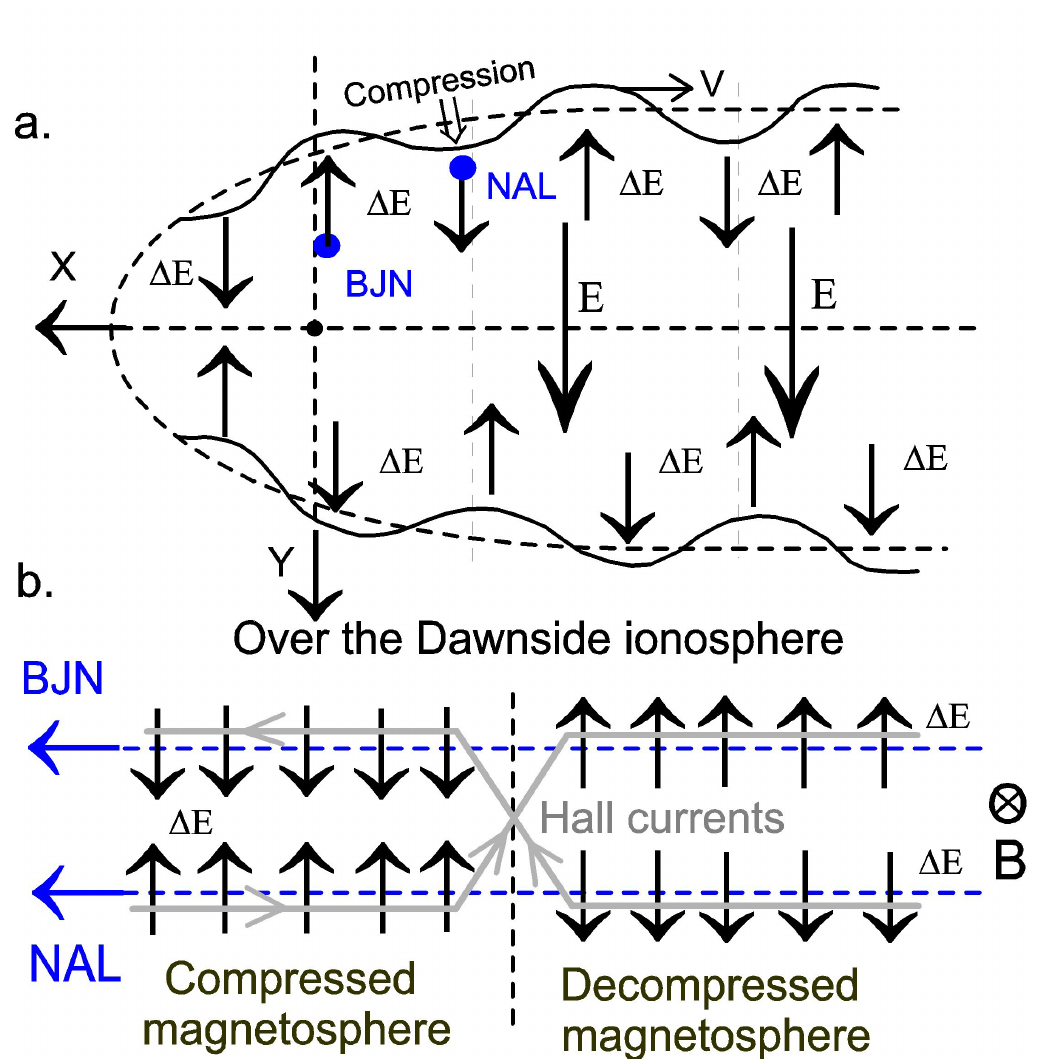
Fig. 12. ( a ) Sketch showing three successive compressions applied over the magnetopause surface from three successive solar wind pressure pulses. Each compression is associated with a local increment 1 E of the cross-tail electric field, which is travelling tailward. The solid circles BJN and NAL are the conjugate points for these stations over the XY plane. ( b ) The increments 1 E travelling tailward and sweeping the BJN and NAL sites over the XY plane are directly mapped over the ionosphere plane. In this sketch the NAL station with the highest latitude and the station BJN as well are assumed to move sunward beneath the ionosphere structure of 1 E considered stationary. The X-line Hall current configuration inferred from ground measurements is drawn with a thick grey